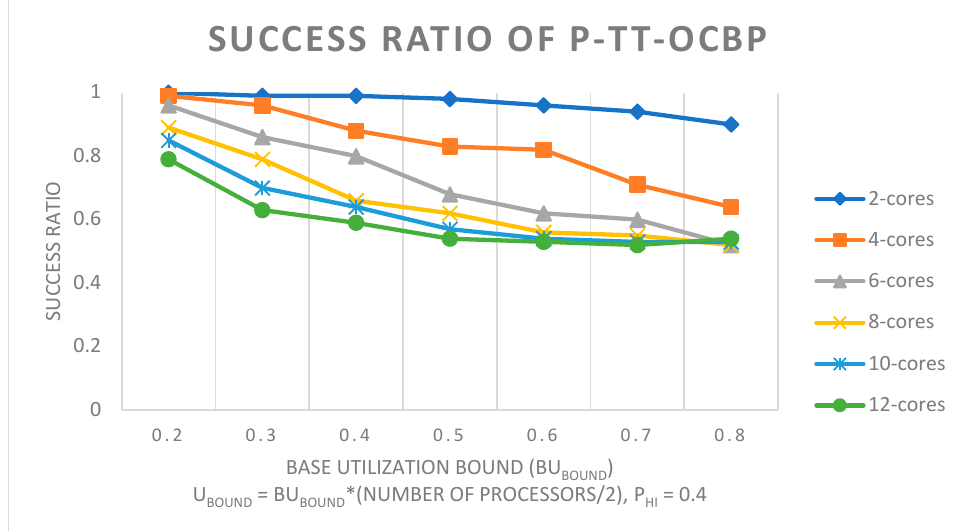
Figure 5. Success ratio of P-TT-OCBP by varying the base utilization bound and the number of processors. U L = 0.05, U U = 0.75, Z L = 1, Z U = 4.